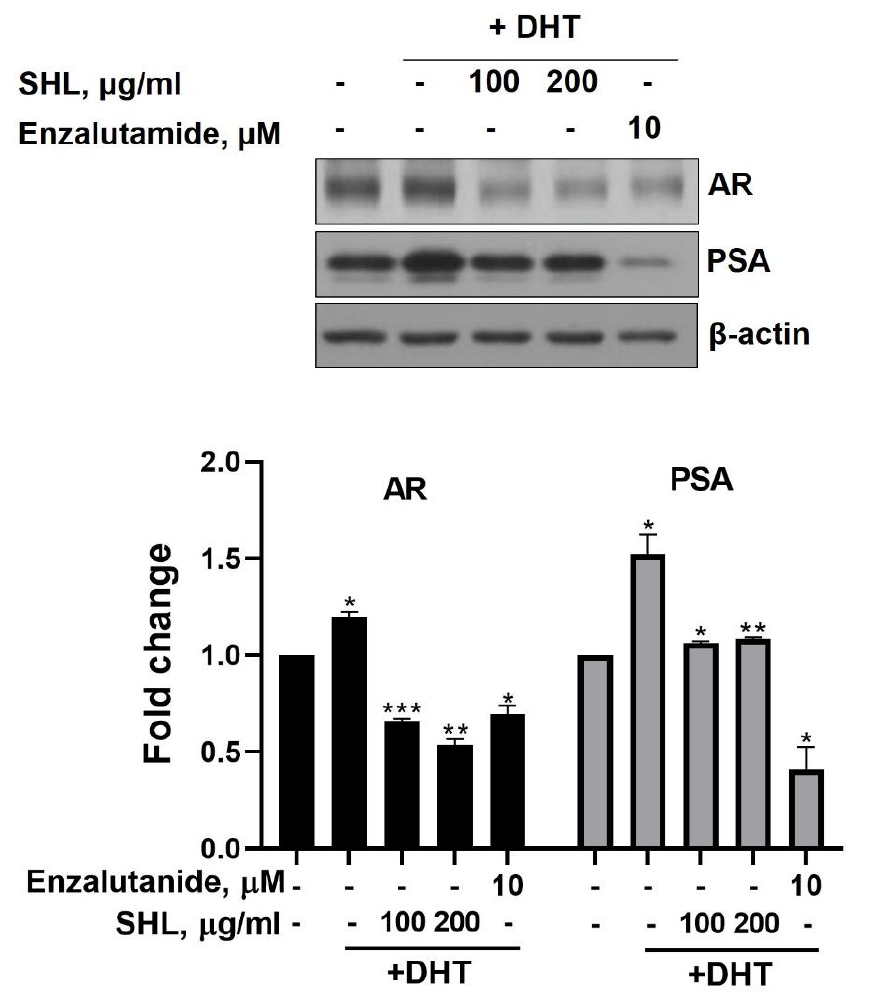
Figure 1. The inhibitory e ff ect of Hippocampus abdominalis (seahorse) lipid extract (SHL) on androgen receptor (AR) and prostate-specific antigen (PSA) expression in DHT-induced LNCaP cells. LNCaP cells were treated with DHT (2 nM) and SHL (100 and 200 µ g / mL) in RPMI 1640 media with 5% charcoal-stripped serum for 24 h; then, the cells were lysed to do Western blotting assay for AR and PSA expression. Bar graph represents the quantification of interest protein related to β -actin, presents as a fold change of control. (*) p < 0.05; (**) p < 0.01; (***) p < 0.001.